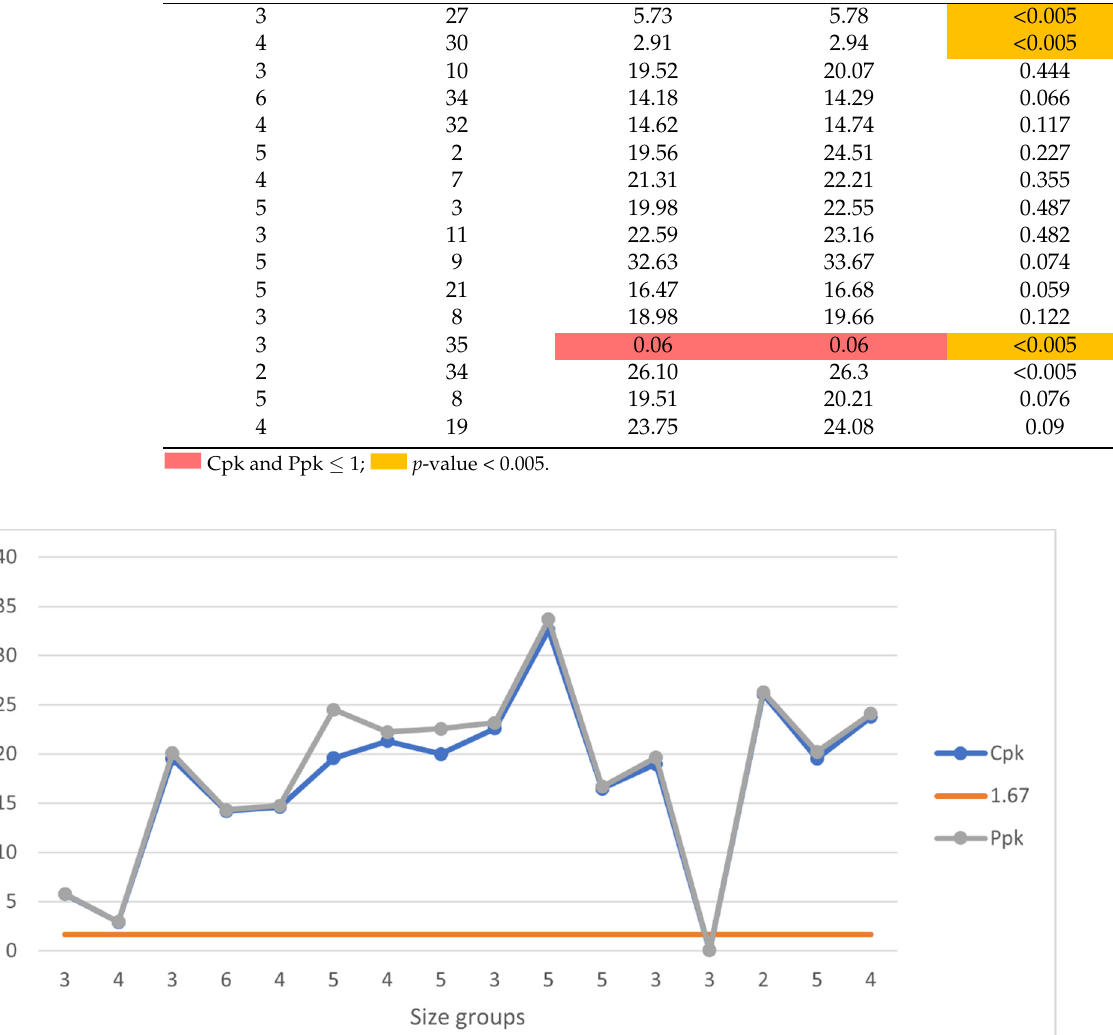
Figure 16. LengthA changes for Tool 3 over number of parts machined. 1,030,0001,032,0001,034,0001,036,0001,038,0001,040,000 0